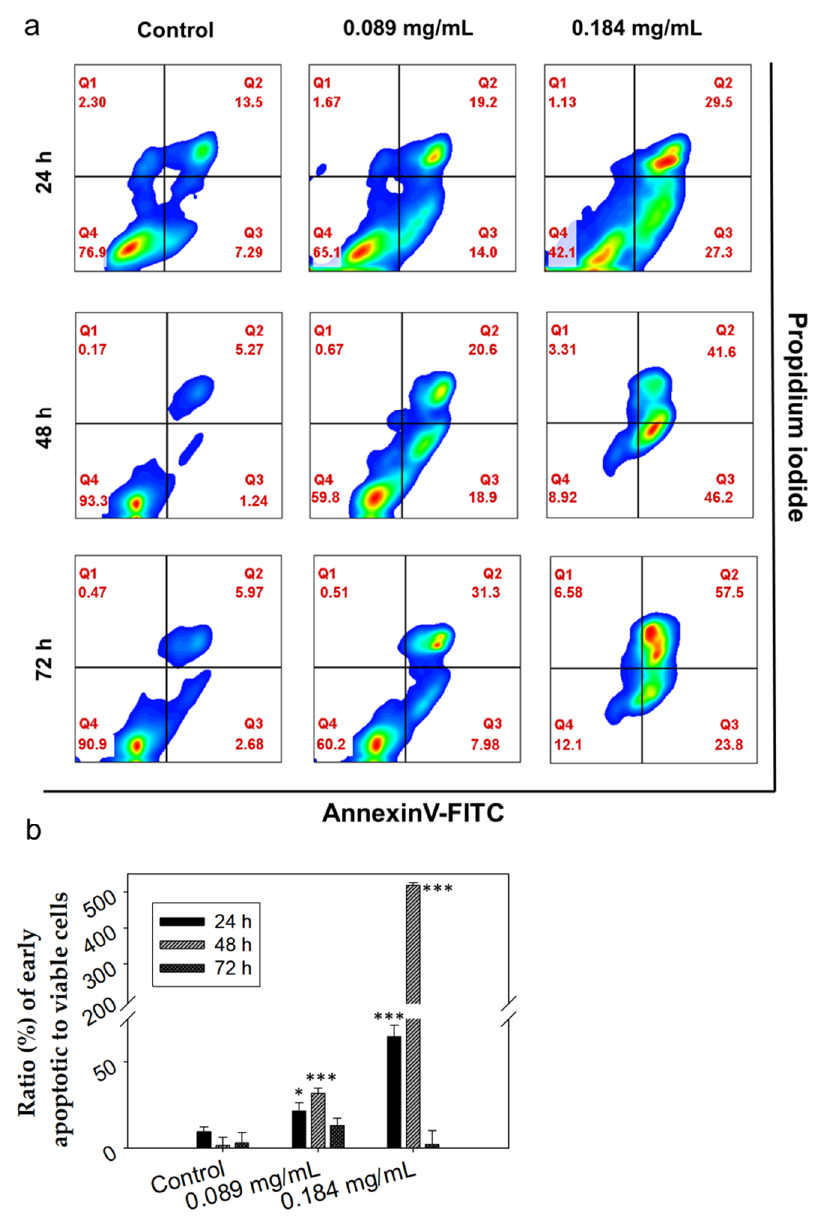
Figure 2. LCO induces apoptotic cell death in DA3 murine breast adenocarcinoma cells detected by flow cytometry. Cells were treated with 0.089 or 0.184 mg/mL of the LCO for 24, 48, or 72 h and stained with Annexin V-FITC and PI before being analyzed by flow cytometry. ( a ) Density plots of control and treated cells. The percentages of viable (Annexin V-FITC and PI negative), early apoptotic (Annexin V-positive and PI-negative), and late apoptotic/necrotic (Annexin V/PI double-positive) cells are indicated on the plots. ( b ) Percentage (%) ratio of early apoptotic to viable cells. At least 10,000 cells were analyzed per sample. Results are presented as the mean ± SD of three independent experiments. Asterisks indicate statistically significant difference between control and treated cells (* p < 0.05, *** p < 0.001 Student’s t -test). This observation indicates that LCO induces concentration-dependent apoptotic ef-